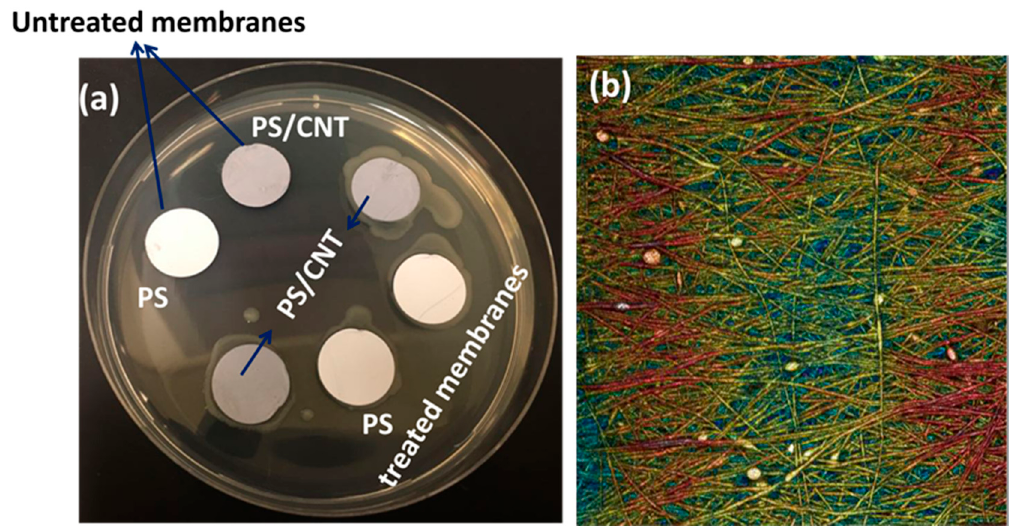
Figure 9. ( a ) Results of antibacterial activity on the E. coli bacteria, ( b ) optical microscope images of E. coli cells on the top of the PS/0.5 wt.% CNT and at 15 KGy gamma-ray irradiated membrane.